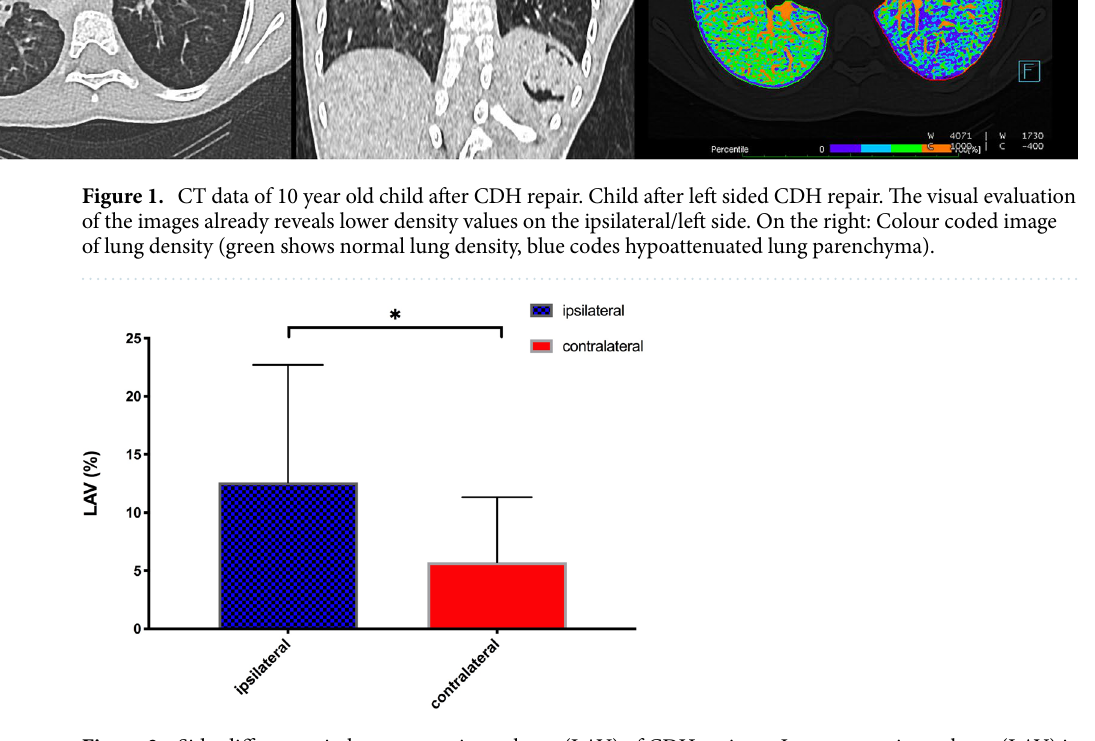
Figure 2. Side-differences in low-attenuating volume (LAV) of CDH patients. Low attenuating volume (LAV) is more frequent on the ipsilateral side in comparison to the contralateral